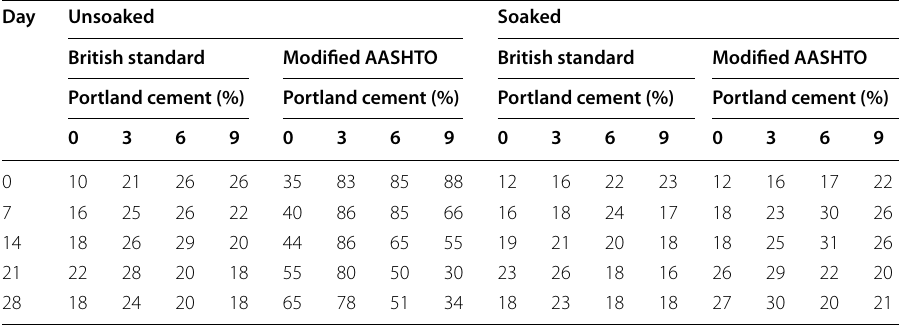
Table 4 Results of CBR and curing days for soaked and unsoaked cement treated material for both BS and modified AASHTO